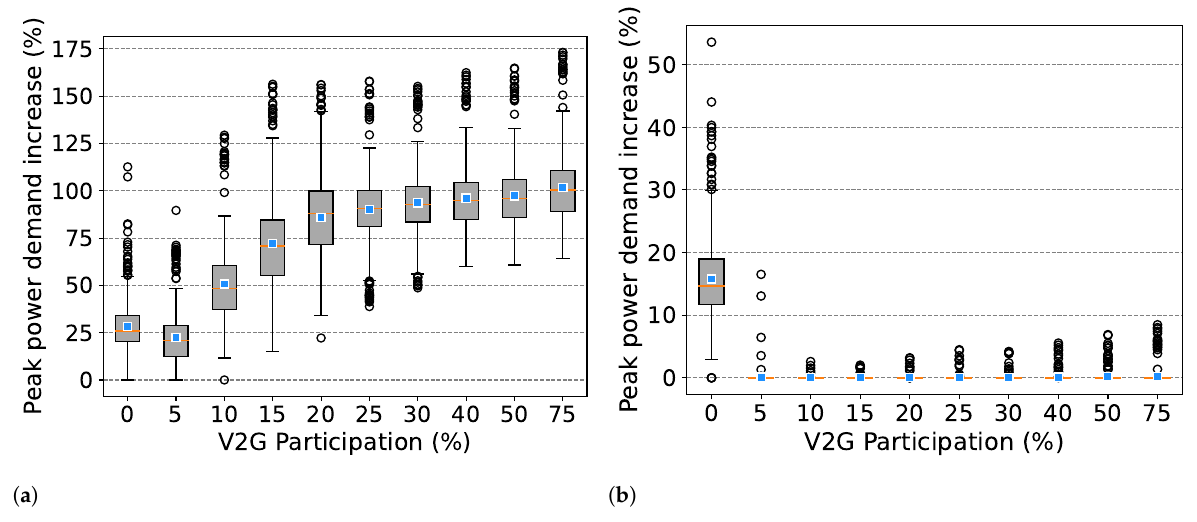
Figure 10. Peak power demand increase in the Berlin LORs with V2G application. ( a ) Summer case. ( b ) Winter case.